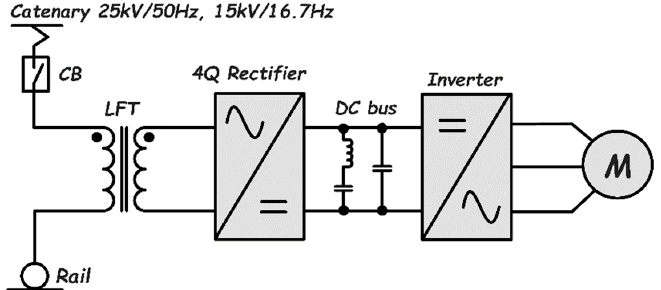
Figure 15. Conventional traction motor drive system based on LFT.